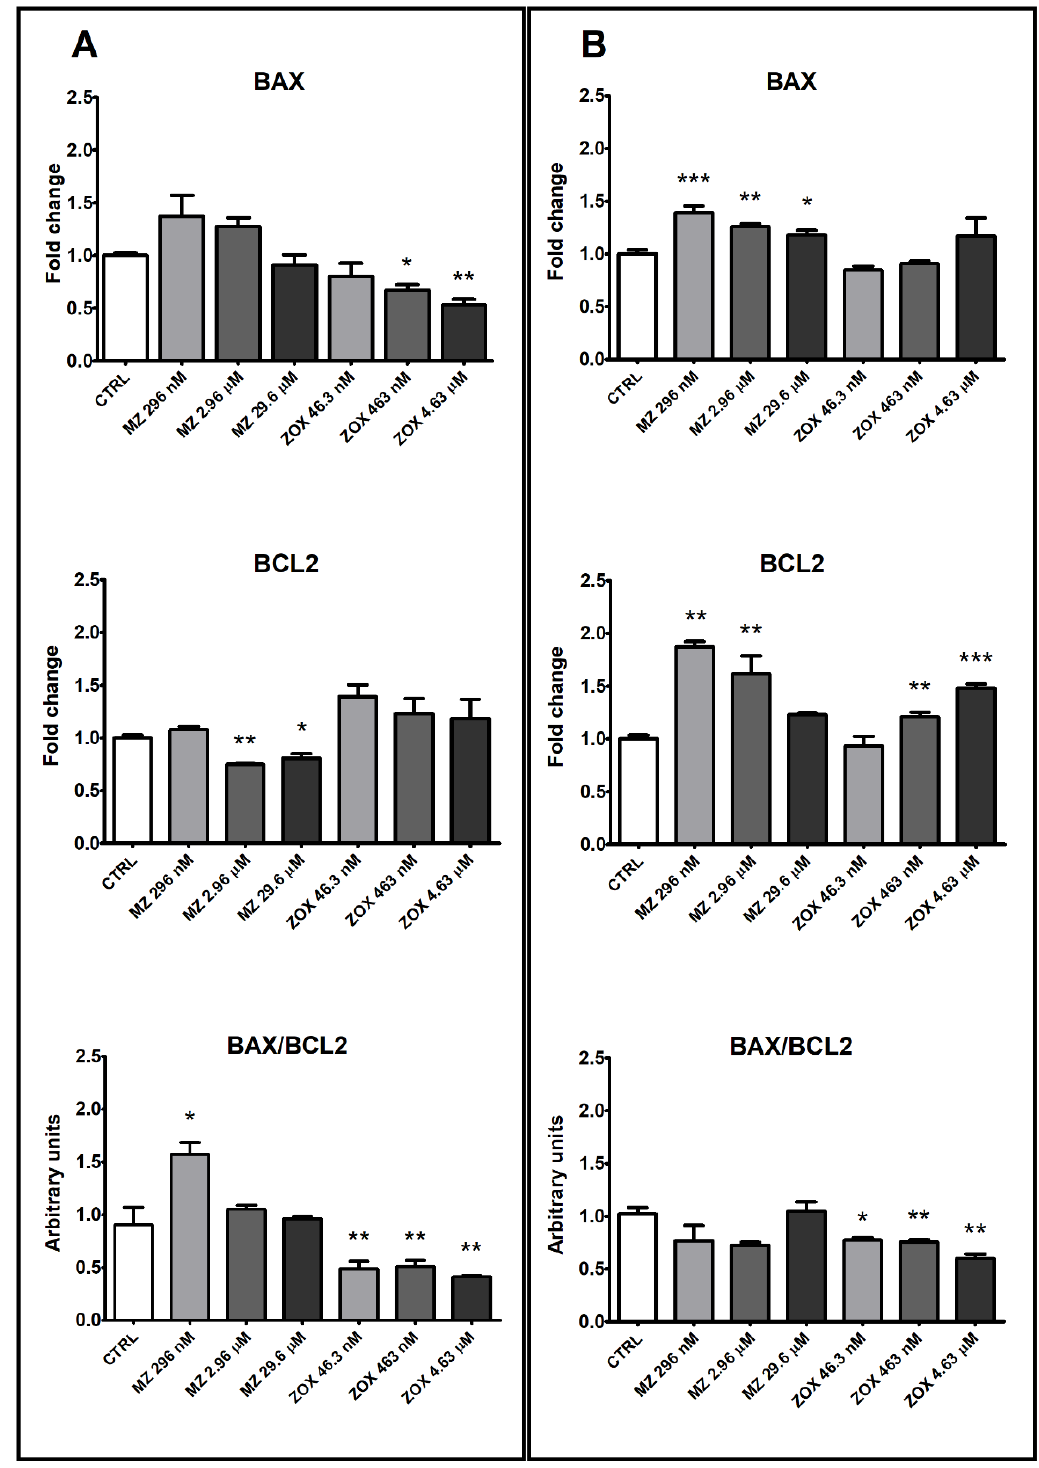
Figure 9. BAX and BCL2 gene expression analysis by real-time PCR in HepG2 ( A ) and A549 ( B ) cells following treatment with MZ, ZOX or medium alone as control for 24 h. Data are mean ∆∆ Ct values ± SEM of three biological replica, with control samples as calibrators and GAPDH as the reference gene. Statistical significance is indicated by asterisks: * p < 0.05; ** p < 0.01; *** p < 0.001.